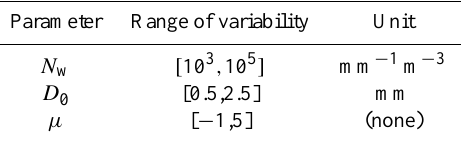
Table 1. The considered variability ranges for the drop size.